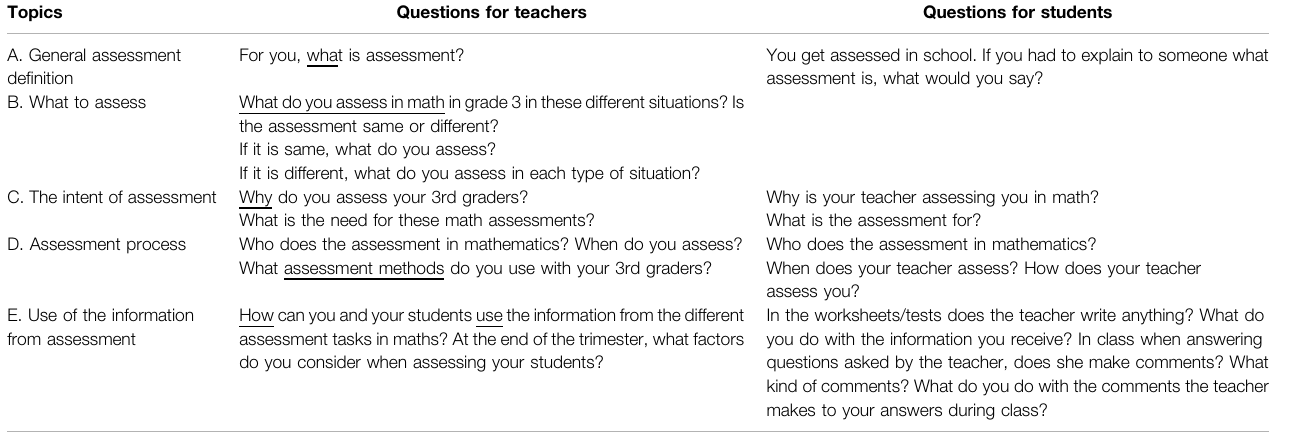
TABLE 1 | Topics and questions of the semi-structured interview protocol.